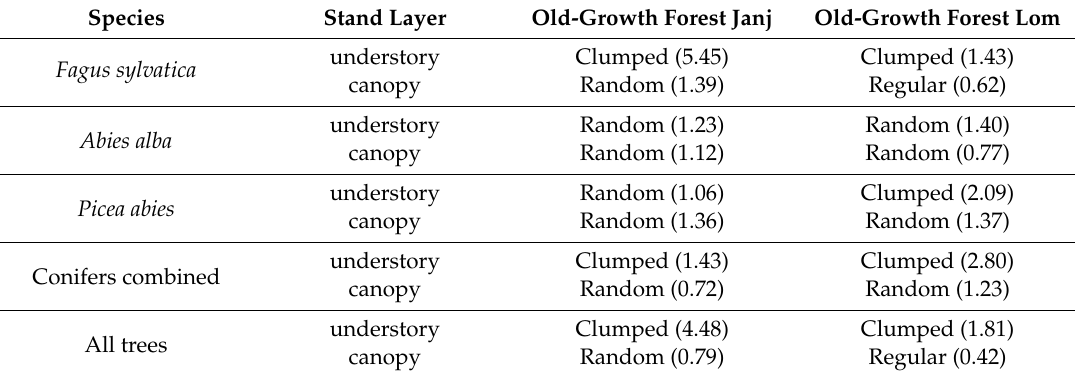
Table 1. The patterns of tree count data in the two studied old-growth forests. The values of the dispersion index ( Ic ) are provided in